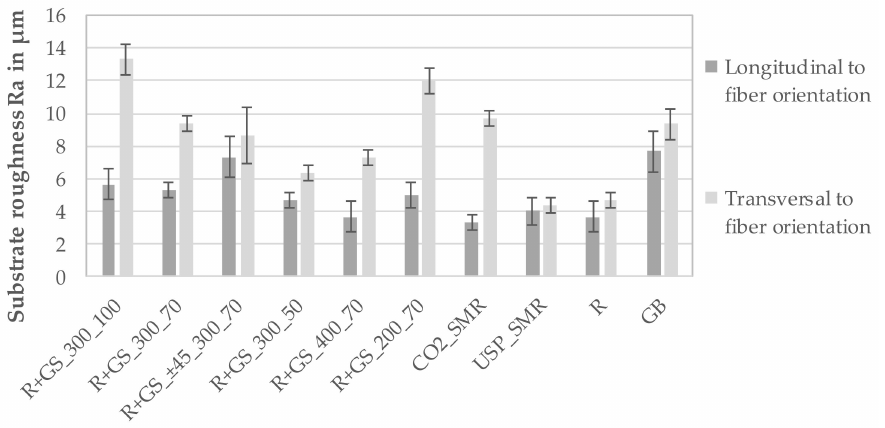
Figure 5. Roughness Ra of all surface structured substrates measured with the CLS